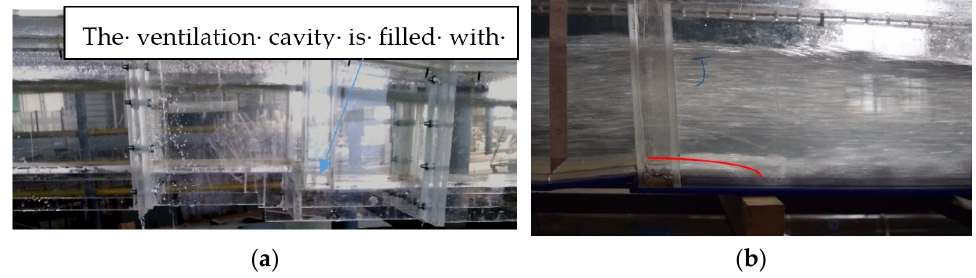
Table 1. Parameters related to model